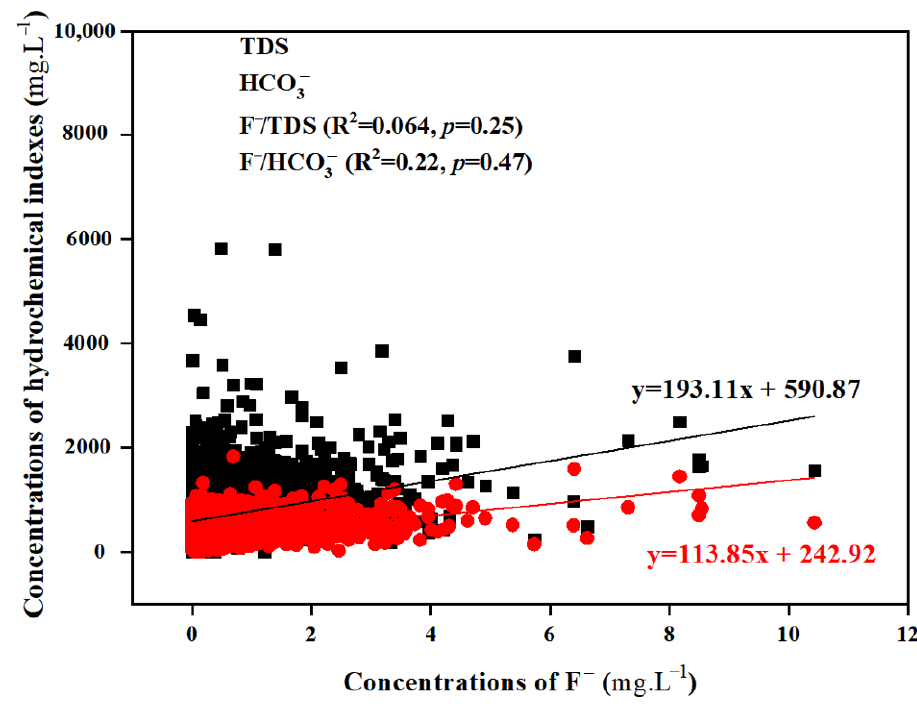
Figure 6. Correlation of F − and Hydrochemical Indices.